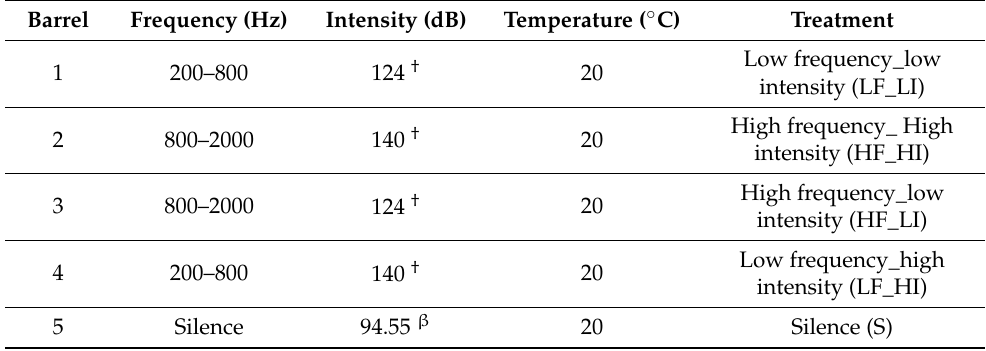
Table 1. Experimental